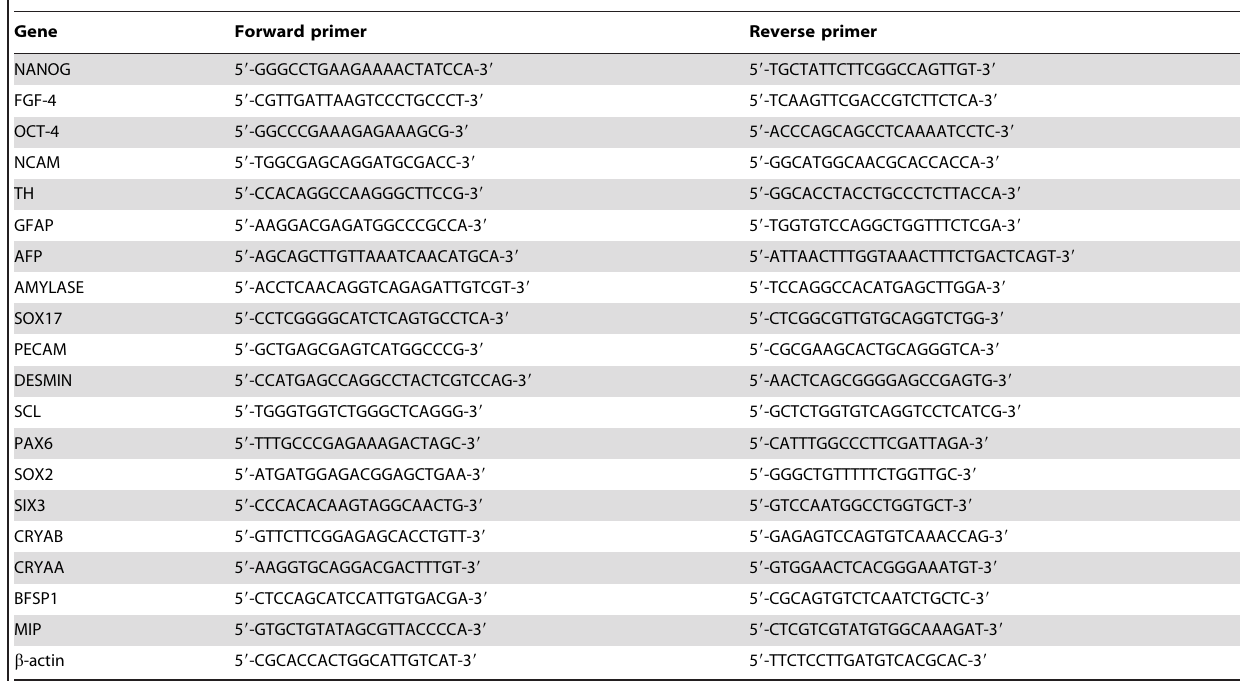
Table 1. Primer sets for each human gene used in qRT-PCR assays.